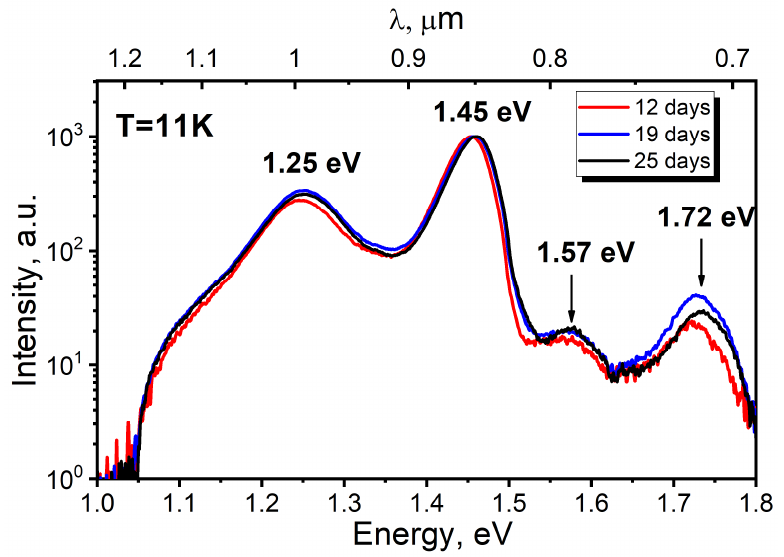
Figure 17. PL spectra of the GaTe / GaAs(001) layer # GT2 measured after di ff erent storage time in vacuum (within three weeks). The PL intensity is normalized to the PL peak with energy of 1.45 eV.